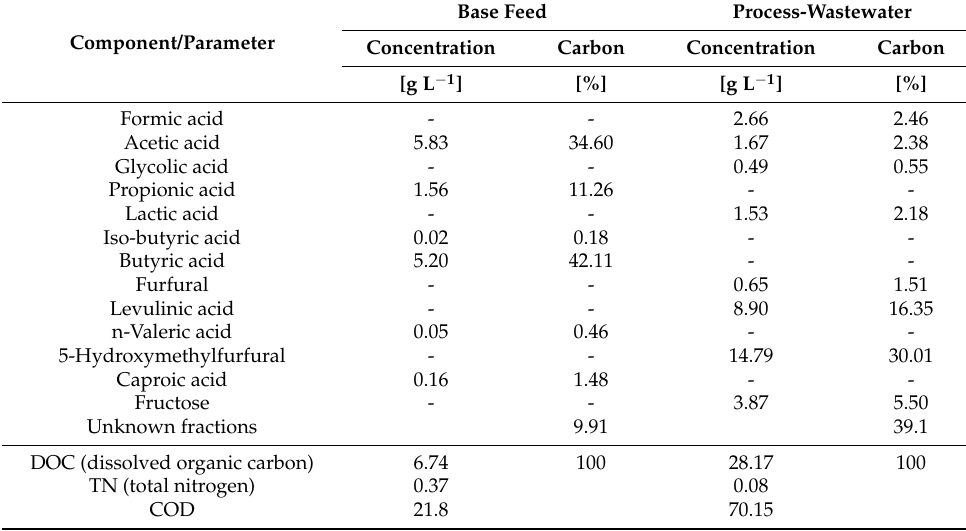
Table 2. Composition of base feed and